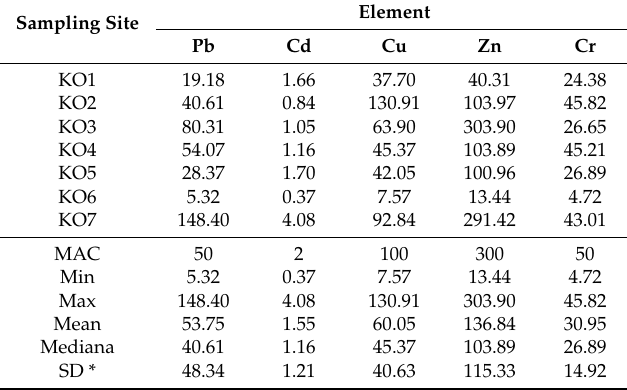
Table 9. Total contents and descriptive statistics of elements in Kotor (KO) urban parks soil samples for this study (mg ¨ kg ´ 1 ).